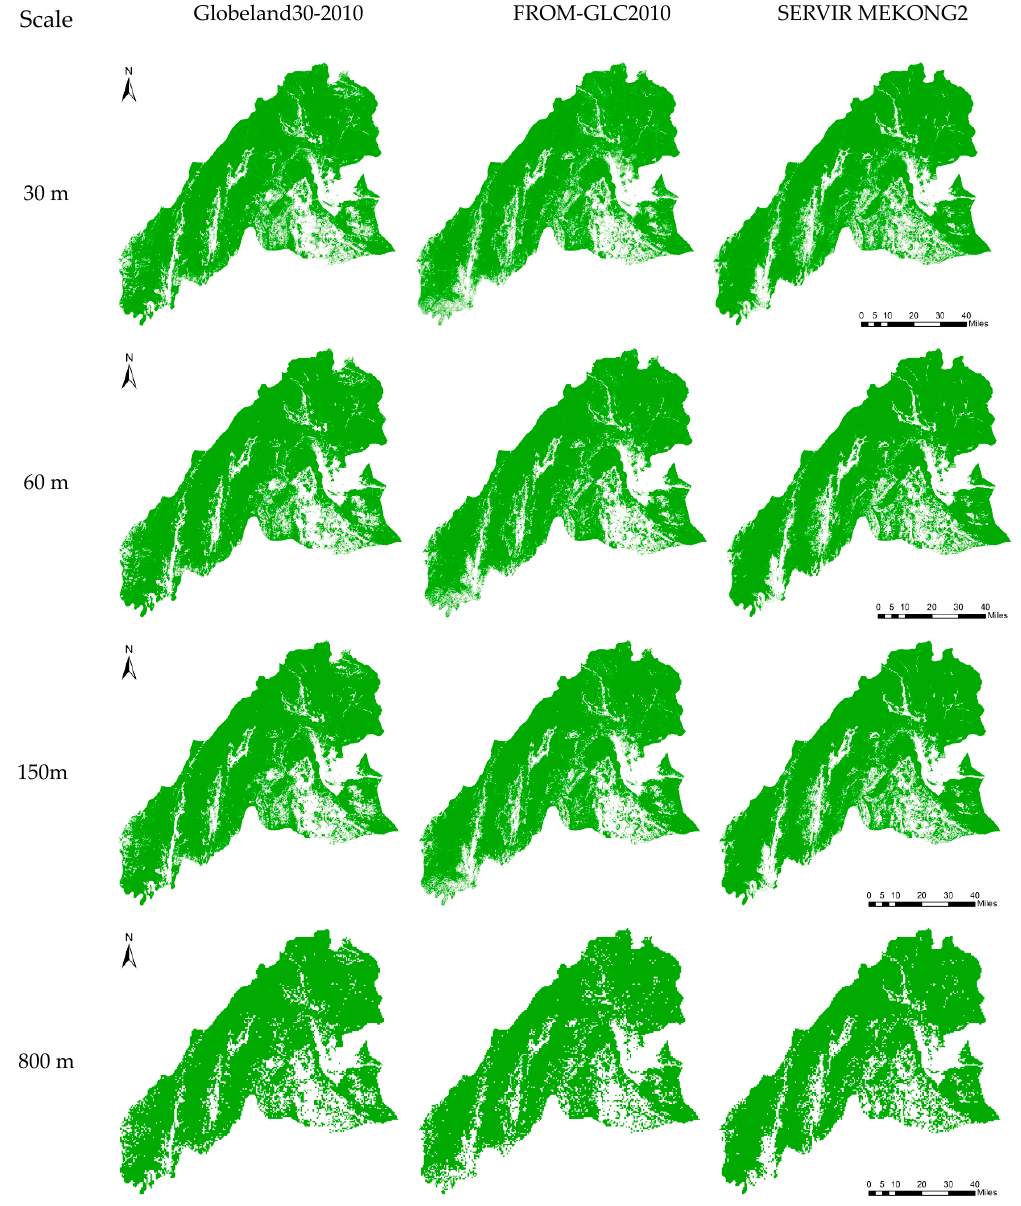
Figure 10. Spatial pattern distributions of three land cover datasets forest type at different scales.